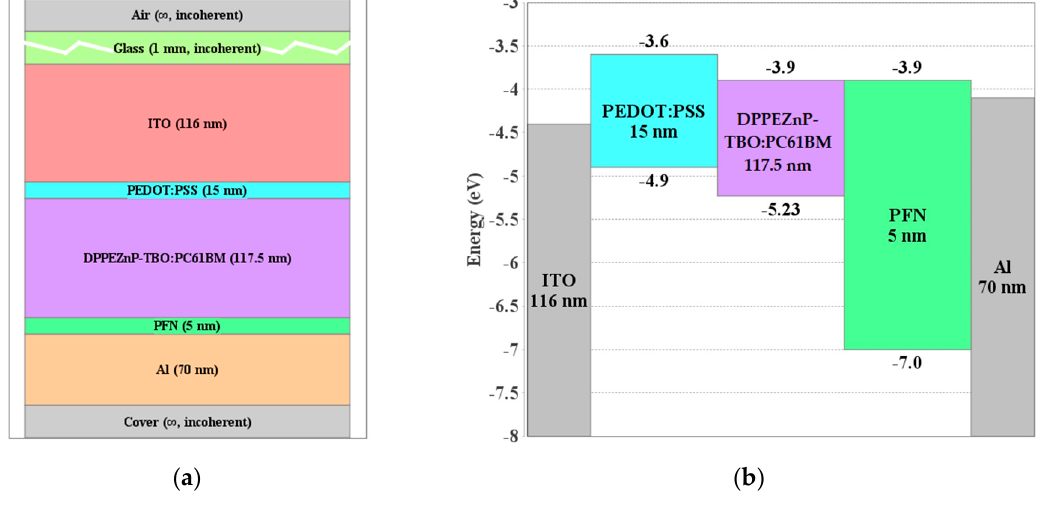
Figure 2. ( a ) Layer stack representing the organic cell structure and ( b ) energy band alignment (before contact) of various layers in the OSC.